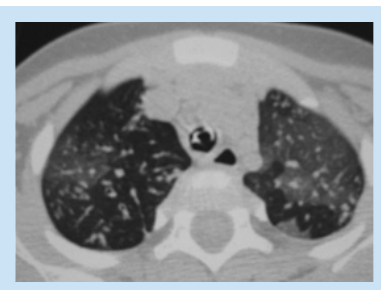
Fig.17a. Bronchiolitis